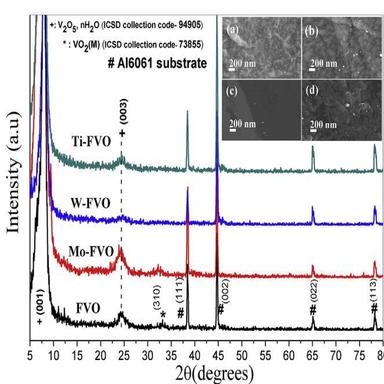
The comparative XRD patterns of the as deposited 2 wt % doped and codoped thin films on the Al6061 substrates .